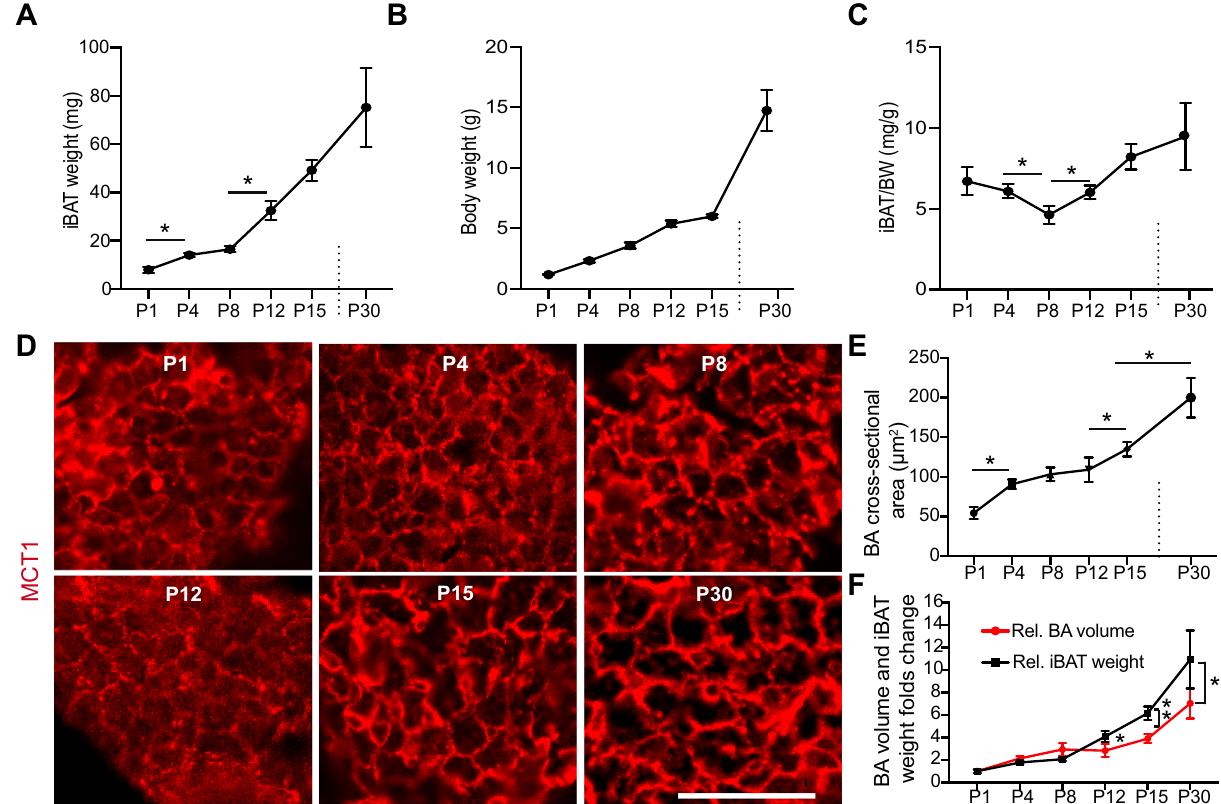
Figure 1. lipogenesis of BAs partially contributes to postnatal iBAT growth. Interscapular brown adipose tissues (iBAT) were collected from mice at postnatal day 1, 4, 8, 12, 15 and 30. ( A,B) Measurement of iBAT weight ( A ) and body weight ( B ) at different ages. ( C) iBAT weight and body weight ratio. ( D ) Immunofluorescence staining images of iBAT tissue at different ages. MCT1 (monocarboxylate transporter 1) antibody was used to visualize plasma membrane of BAs. Bar = 50 µm. € Quantification of cross-sectional area of BAs. N = 4–6. ( A , C and E ) One-way ANOVA post-hoc Tukey’s multiple comparisons test, * P < 0.05; *** P < 0.001. ( F) Folds change comparison between iBAT weight and brown adipocyte volume. iBAT weight and brown adipocytes volume at different ages were normalized to the corresponding values of P1, respectively. Student t test, * P < 0.05; ** P < 0.01. N =